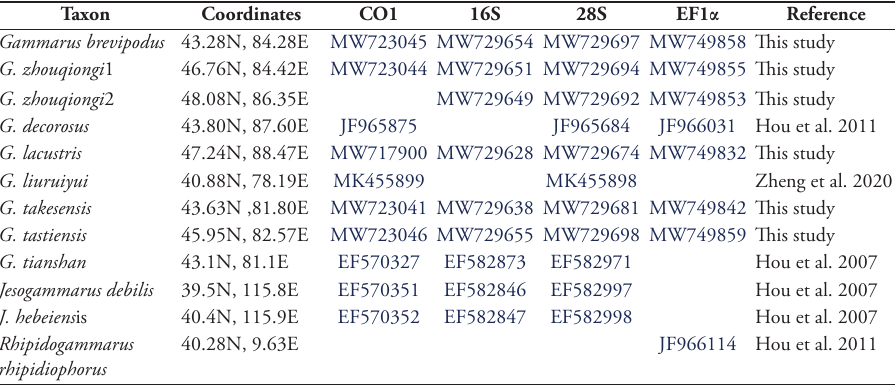
Table 2. Taxon information and Genbank numbers for the complete